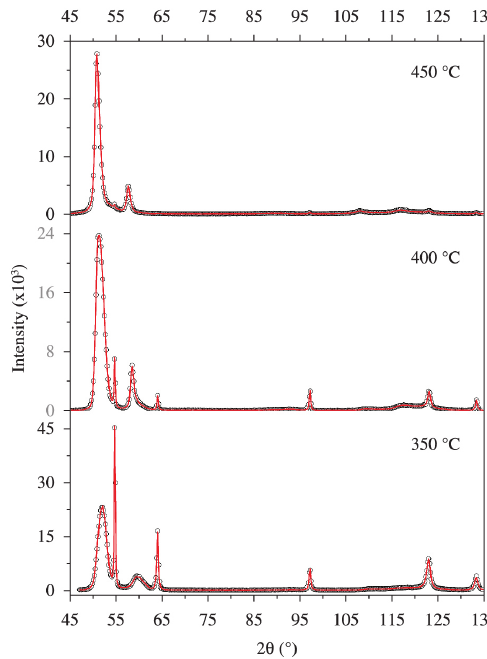
Figure 2. Fitted X-ray diffraction patterns for the samples nitrided for 3h at different temperatures.